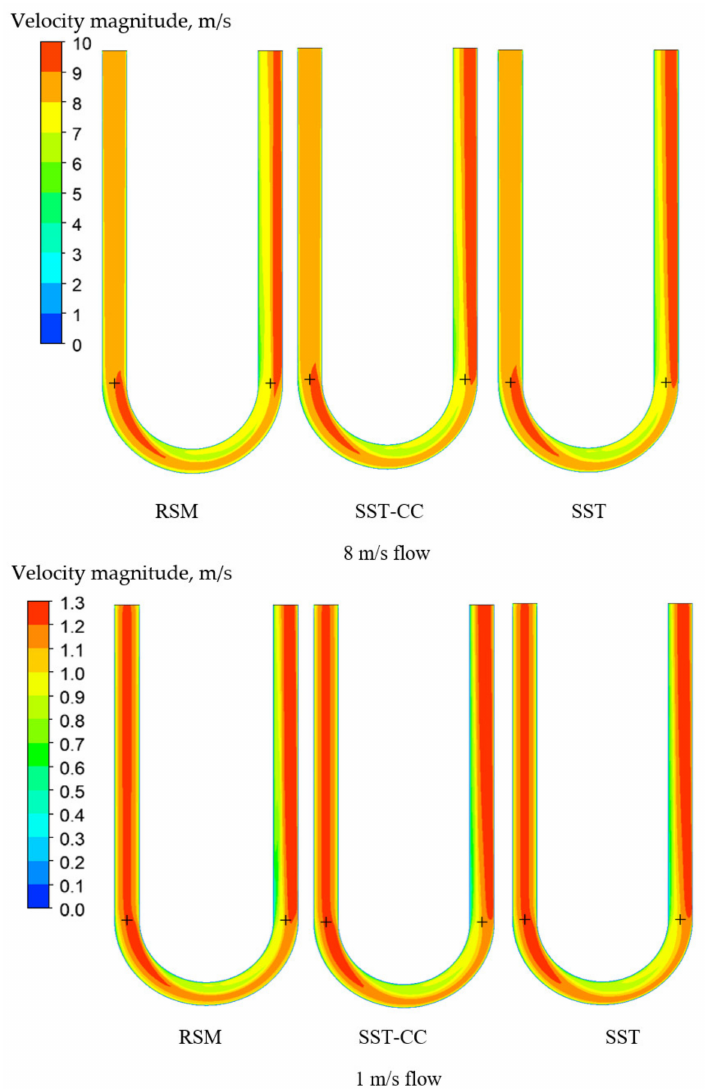
Figure 11. Velocity fields for the Case D for the shear stress (SST) and Reynolds stress (RSM) turbulence models at different flow